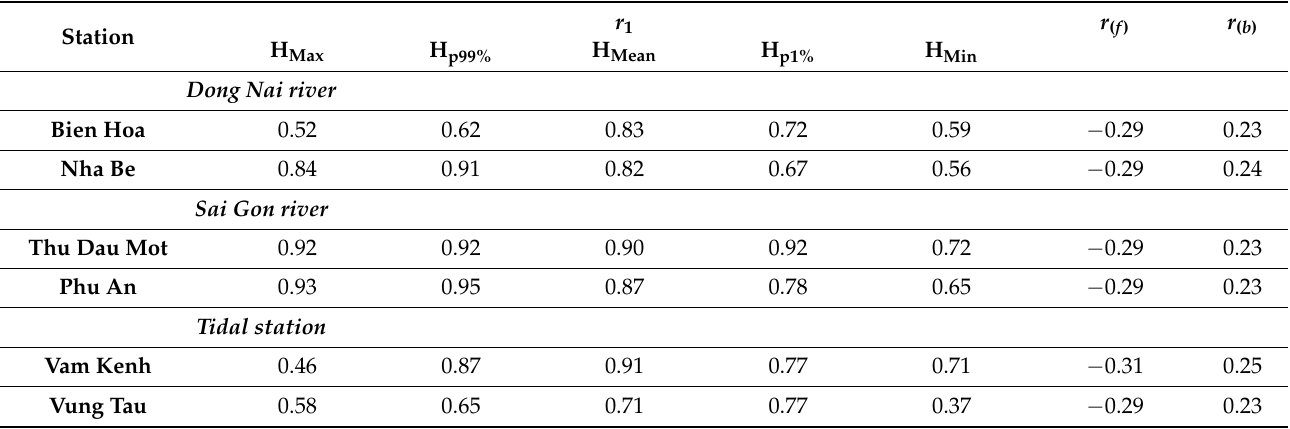
Table 2. The effects of autocorrelation of data